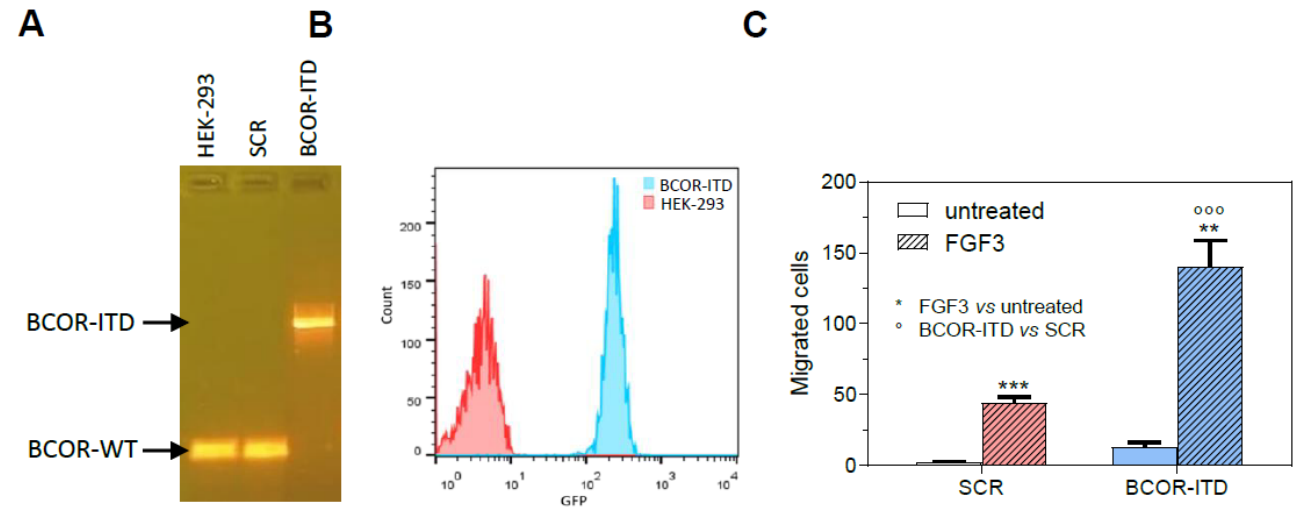
Figure 3. ( A ) PCR detection of BCOR-ITD construct integrated in the last exon of BCOR in HEK BCOR-ITD and not the parental HEK-293 cell line or scramble clone (SCR). ( B ) Flow cytometry detection of GFP fluorescence in BCOR-ITD and not in HEK-293 parental cell line. ( C ) Migration induced by FGF3 10 ng/mL in BCOR-ITD and SCR clones with respect to untreated cells (**, p < 0.01; ***/°°°, p < 0.001).